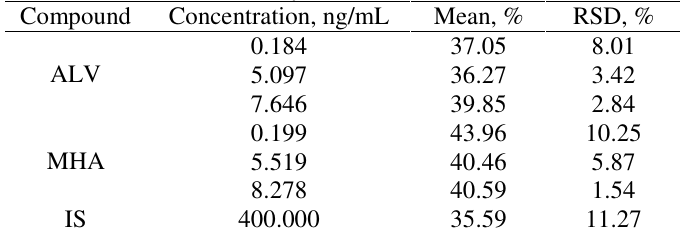
Table 2. Recovery of ALV and MHA ( n =